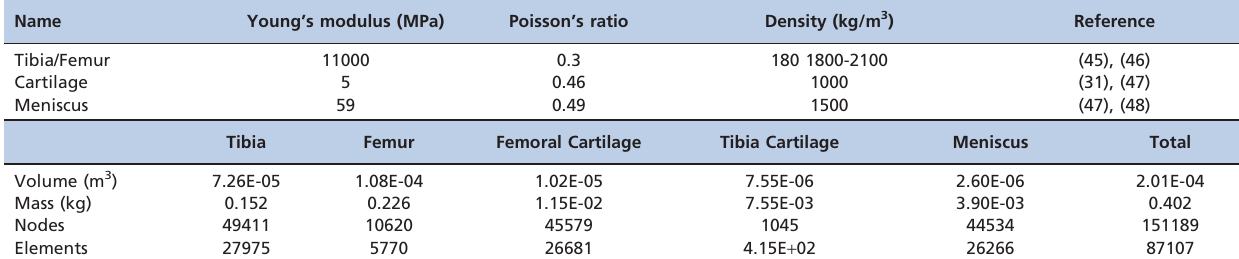
Table 1 - (I) The mechanical property of knee components. (II) Knee component’s finite element data.